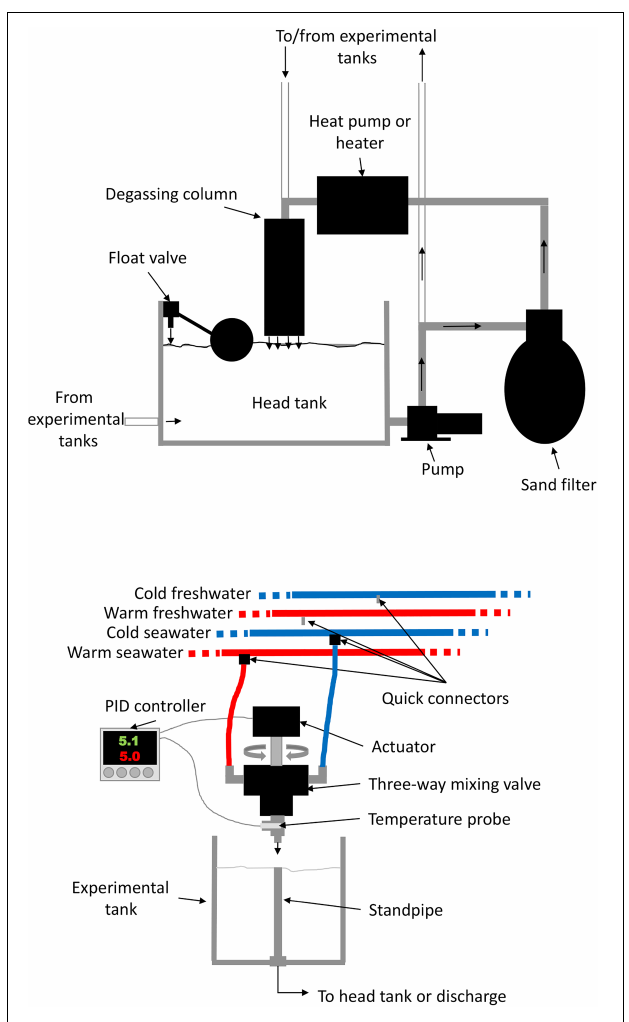
FIGURE 2 | Diagram showing one of the 40 systems used to manipulate temperatures and salinity in the experimental tanks and one of the four systems used to condition the